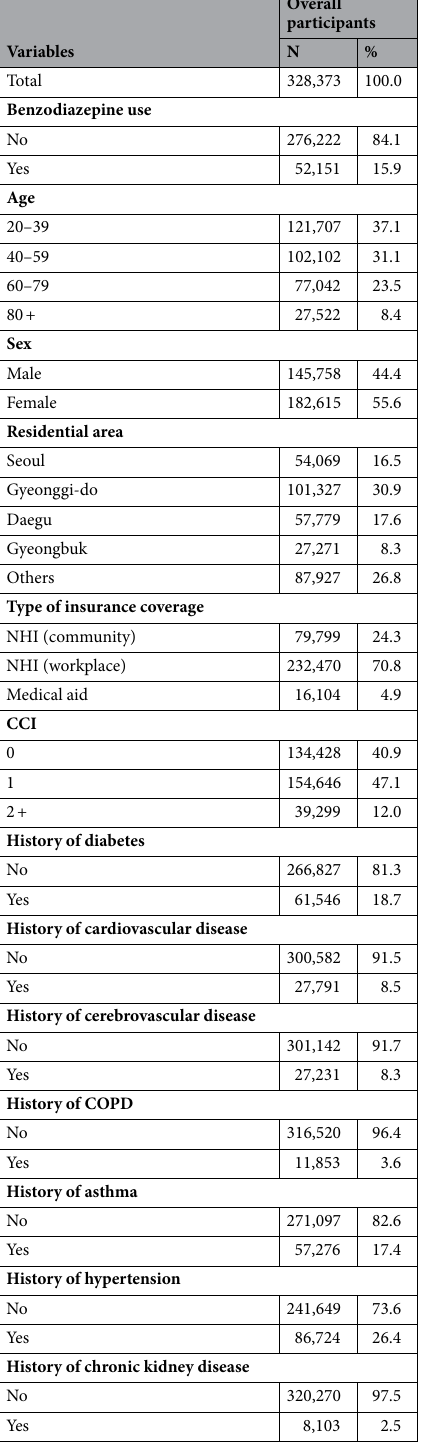
Table 1. General characteristics of the study population. All individual characteristics were surveyed as of 2020, and the last survey was recorded until the end of May 2020. NHI National health insurance, CCI Charlson Comorbidity Index, COPD chronic obstructive pulmonary